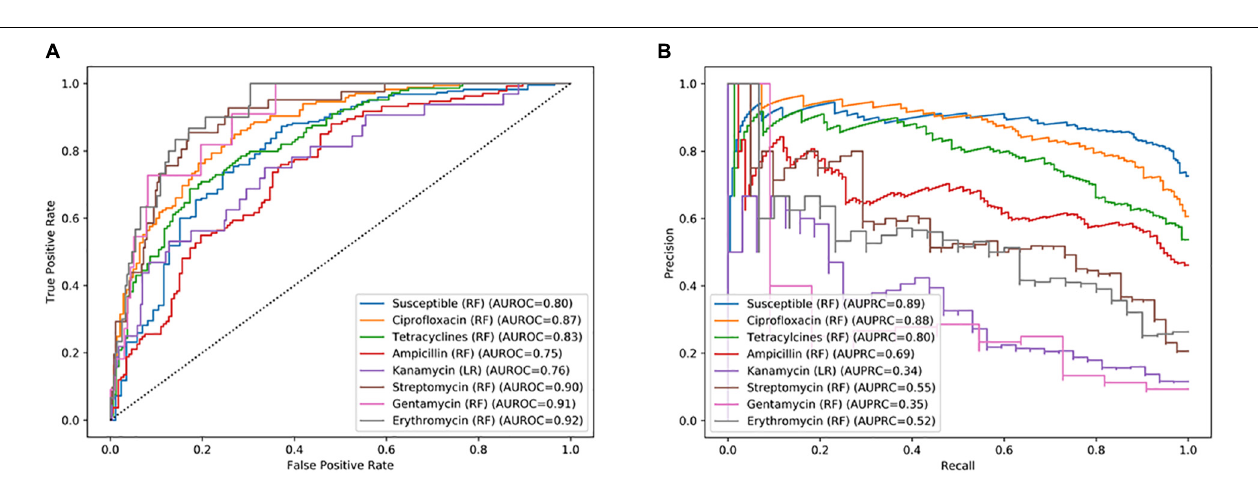
FIGURE 2 | Biological reproducibility of MALDI-TOF mass spectra based on their protein extraction type and species level. Boxplots show the isolates average similarities in percentage. Green triangle represented the mean. Direct, direct deposit; FA, formic acid extraction; EtOH, ethanol/acetonitrile